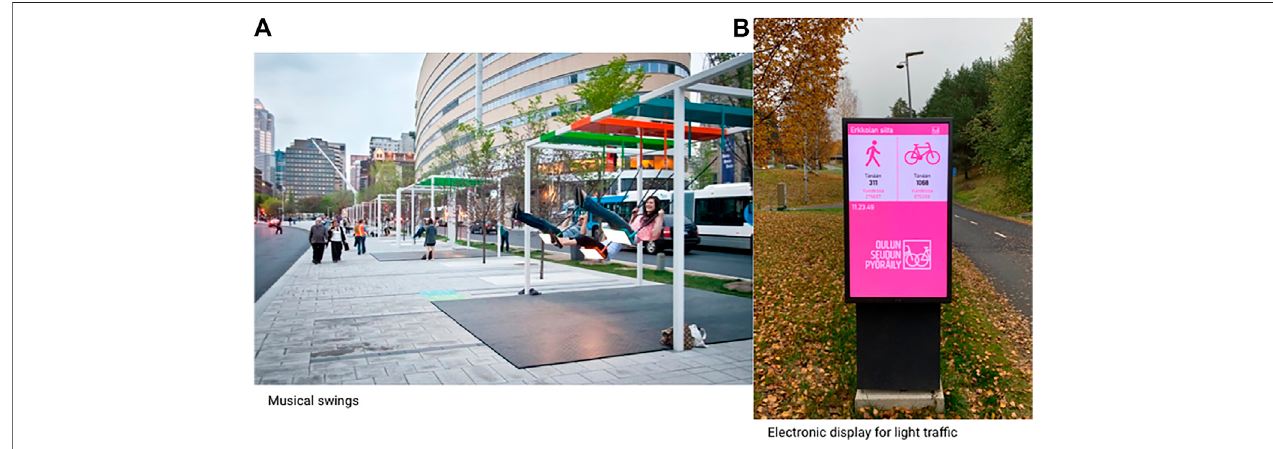
FIGURE 1 | 21 Balançoires (21 Swings) and Display for light traf fi